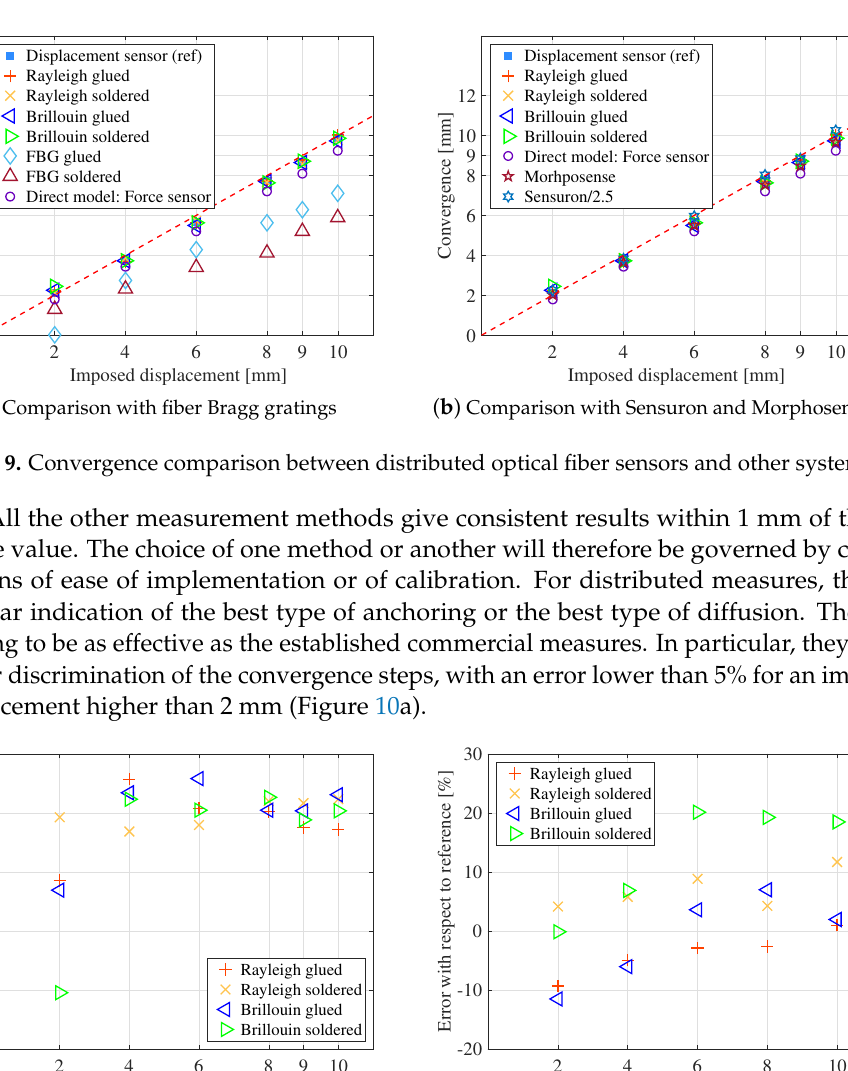
Figure 8. Measurements with Sensuron sensor and Morphosense sensors. ( a ) Sensuron 3D shape sensing: structure coordinates. ( b ) Morphosense convergence for each different MEMS sensor, with the original ring shape in a continuous blue line.